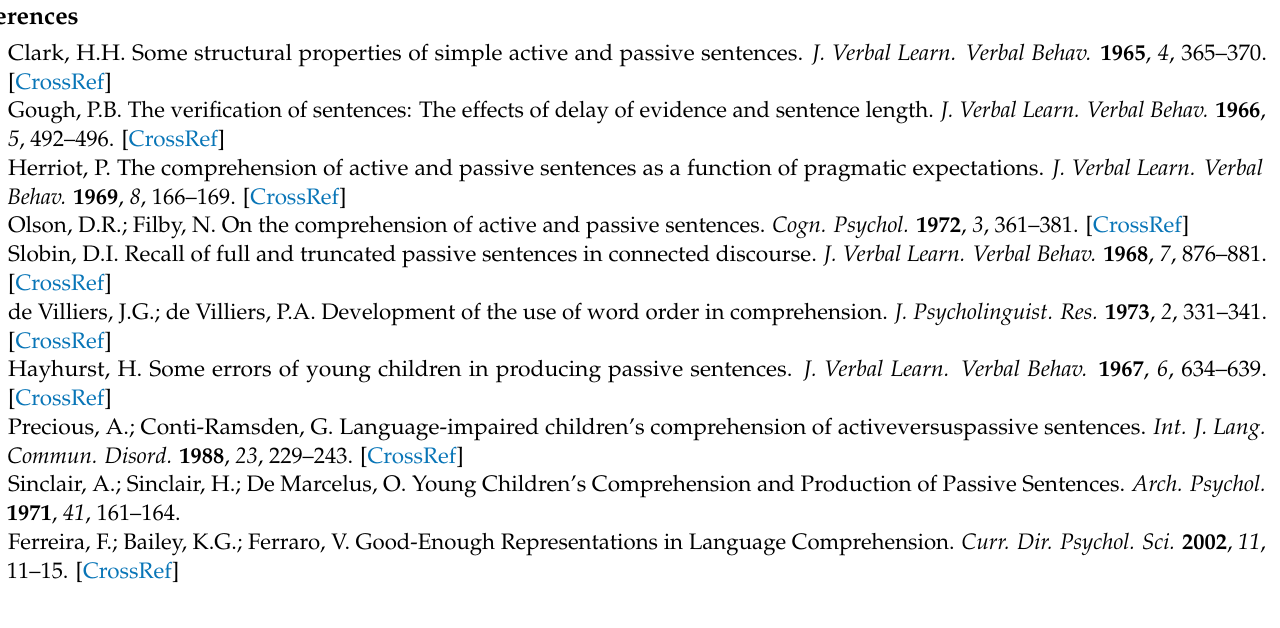
Table S3: Mean reading times (msec) and regressions for correct and incorrect responses by group and experimental